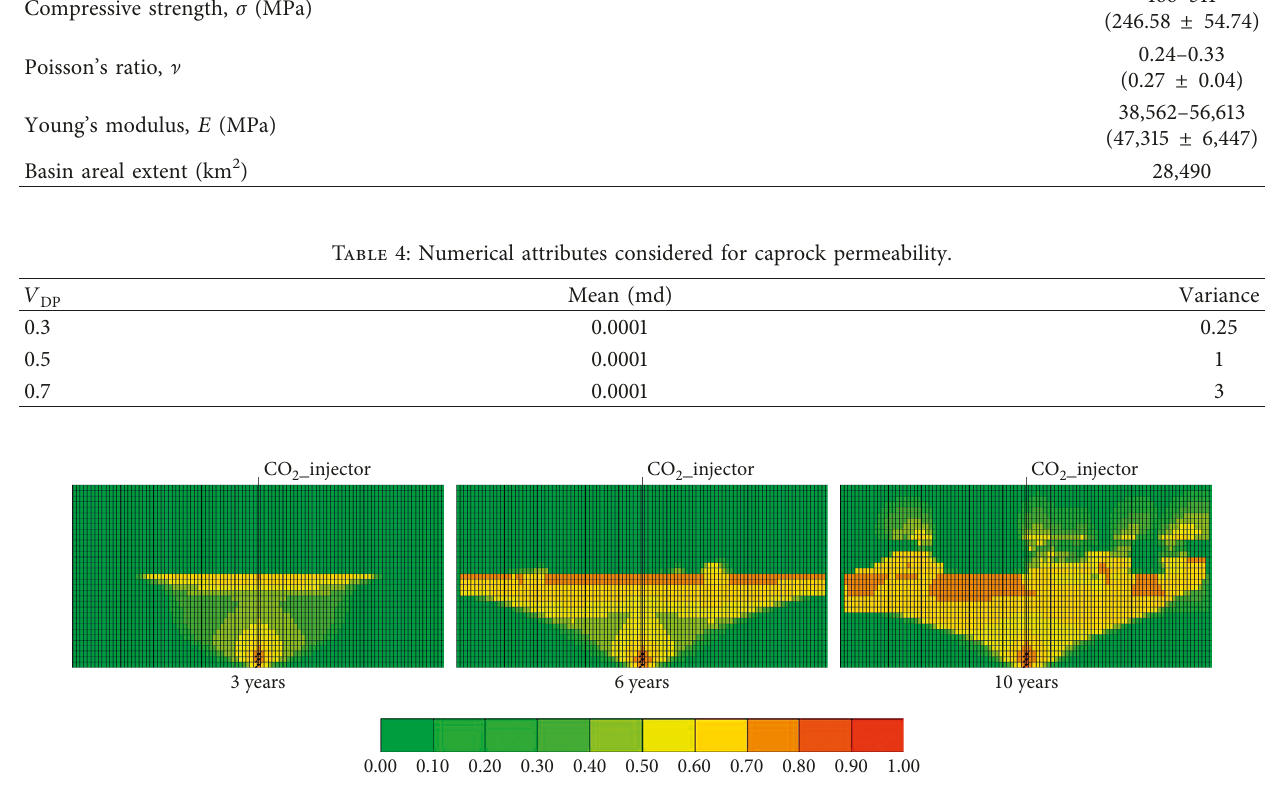
Figure 5: Gas saturation of single realization for V